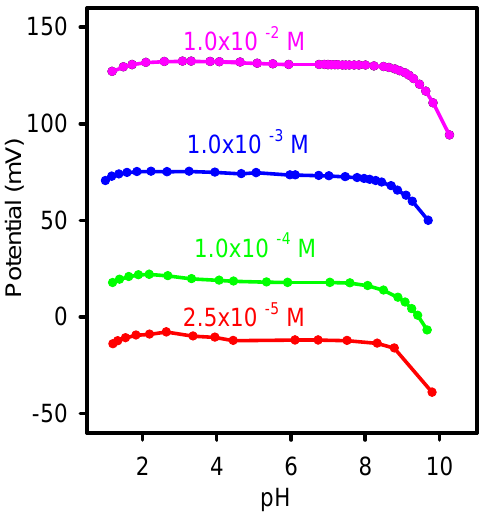
Figure 2: Influence of pH at different tiapride concentrations